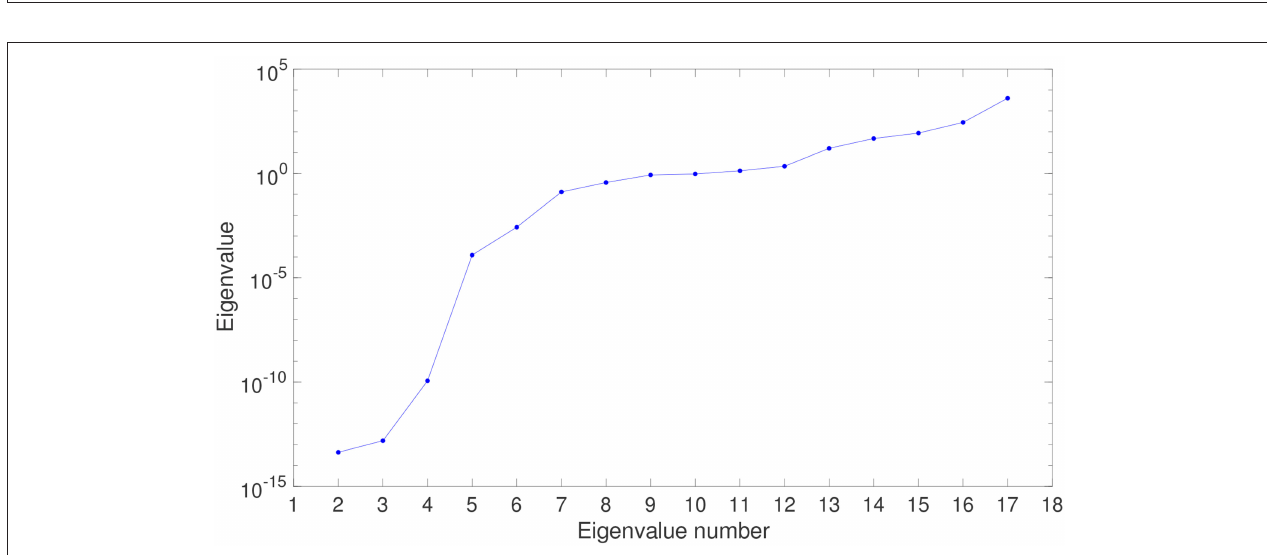
FIGURE 4 | Comparison of the Mooney-Rivlin model prediction and its subsequent GENERIC correction with the experimental results for one particular experiment.